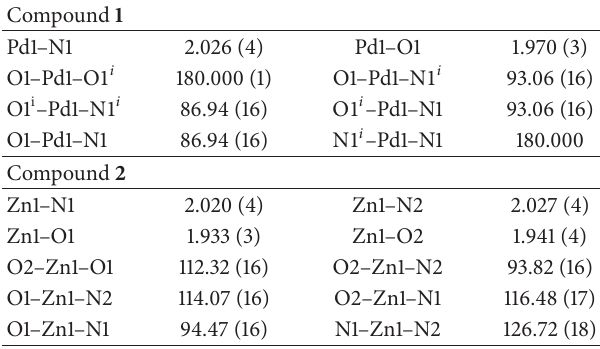
Table 1: Crystal and refinement data. Table 2: Selected bond length and angles of 1 - 2 .